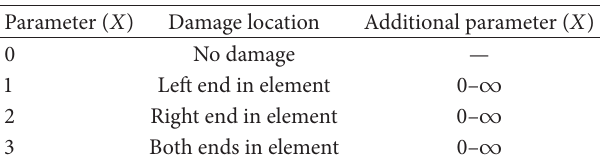
Table 1: Parameter settings. Table 2: Measured natural